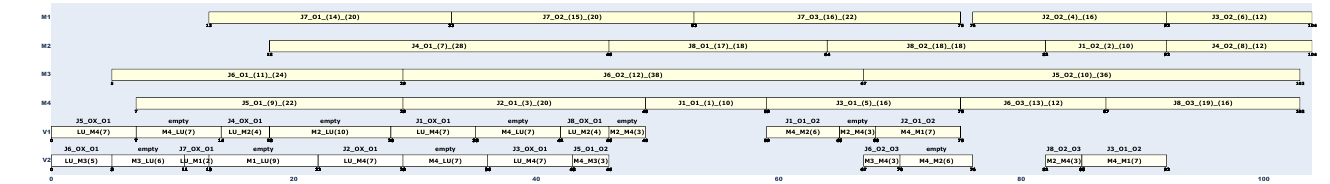
Figure 9. Gantt chart for improved solution of EX_740 instance from Kumar, Janardhana and Rao [11] .